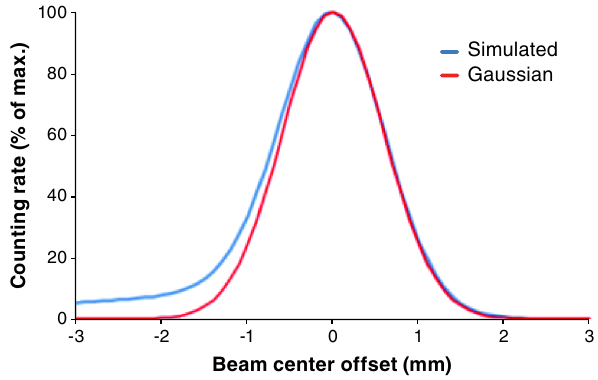
FIG. 19. Simulated relative counting rates as a function of horizontal electron-ion beam offset for the case illustrated in Fig. 18. Also shown (in red) is the ideal convolution of the two Gaussian beams in absence of the asymmetric